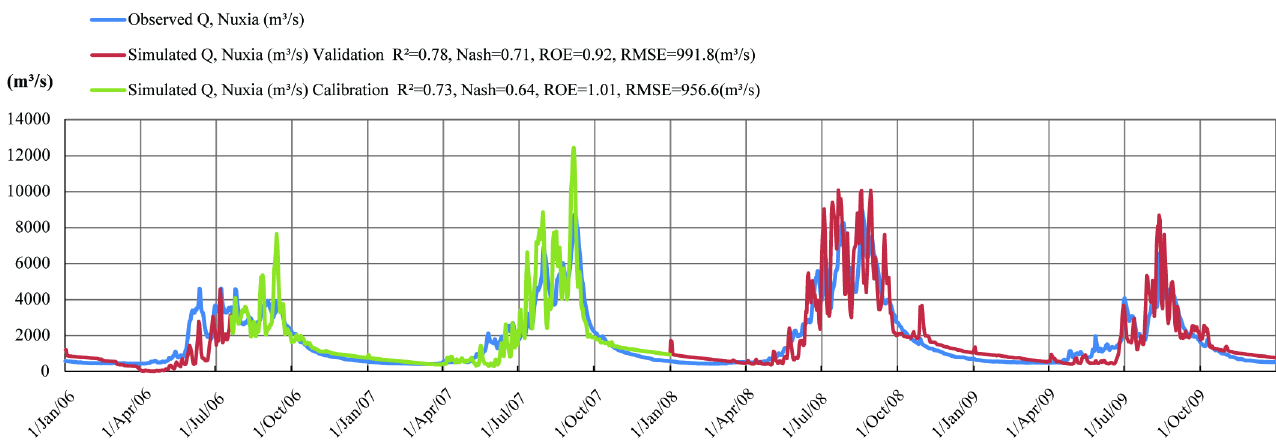
Fig 5. The observed and simulated runoff hydrographs at Nuxia for both calibration and validation periods.